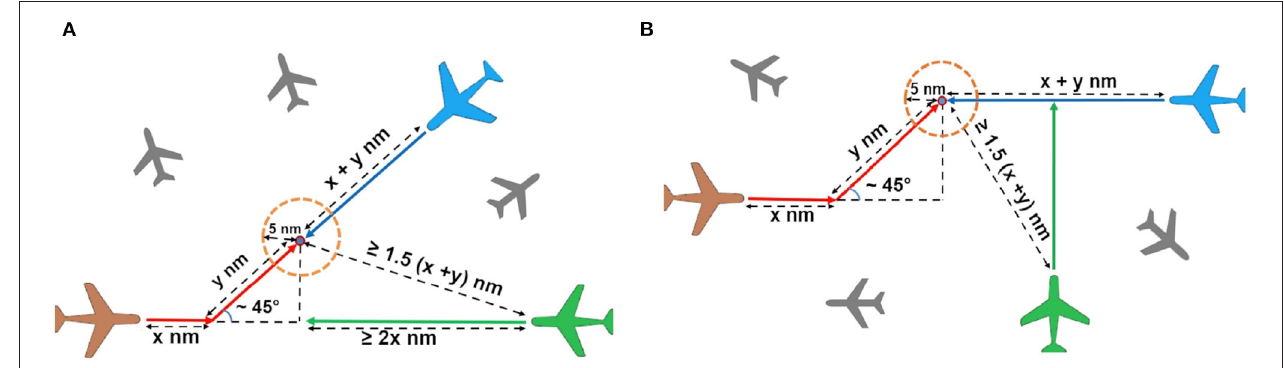
FIGURE 4 | Conflict event models A (A) and B (B) . Algebraic symbols and equations specify the length of the path segments of the air routes (not drawn to scale) and their topological relationships. These routes were kept hidden from participants’ view. Colored aircraft represent aircraft cruising on the same flight level while gray aircraft in the background represent aircraft cruising at flight levels different from that of the former cluster. On the same flight level, a non-conflicting aircraft in each model (colored in green) was placed initially at a safe distance away from the conflict zone, which is represented by the dotted circle with a radius of 5.0 nm. The total number of non-conflicting aircraft located in the vicinity of two conflicting aircraft that constituted each conflict event increased from one in the low air traffic density (ATD) condition to three and five in the medium and high ATD conditions, respectively (see text, for more